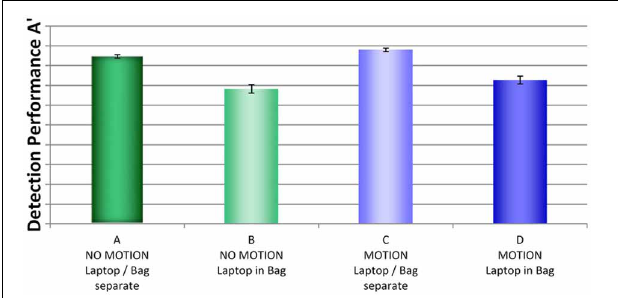
FIGURE 4 | Mean detection performance A’ with standard errors of the mean for all four conditions (A–D). For security reasons, actual A’ performance scores are not